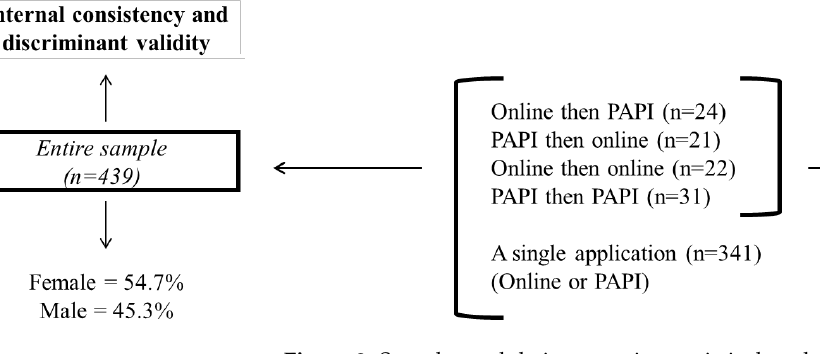
Figure 2. Samples and their respective statistical analyses.